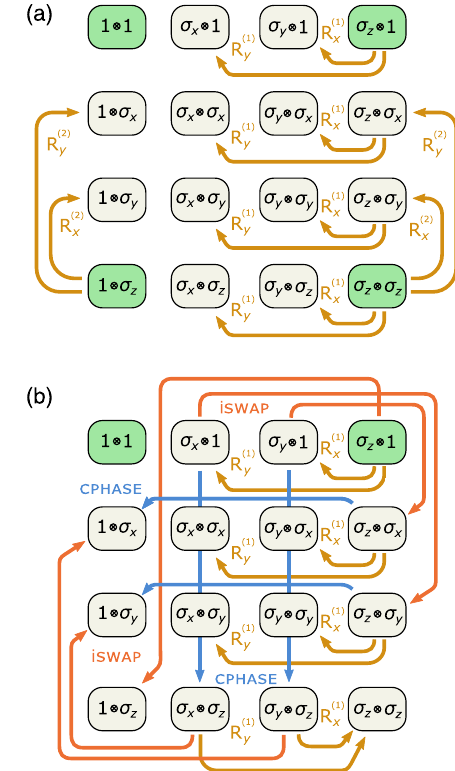
FIG. 3. Accessibility of the entire space of two-qubit measure- ment operators (a) in the normal case with full control and readout of both qubits and (b) with the second qubit hidden. The native measurement operators in each case are marked in green while the arrows show transformations of the measurement operators by different gates applied prior to the measurement. R ð j Þ x and R ð j Þ y denote π = 2 rotations around x and y applied to qubit j